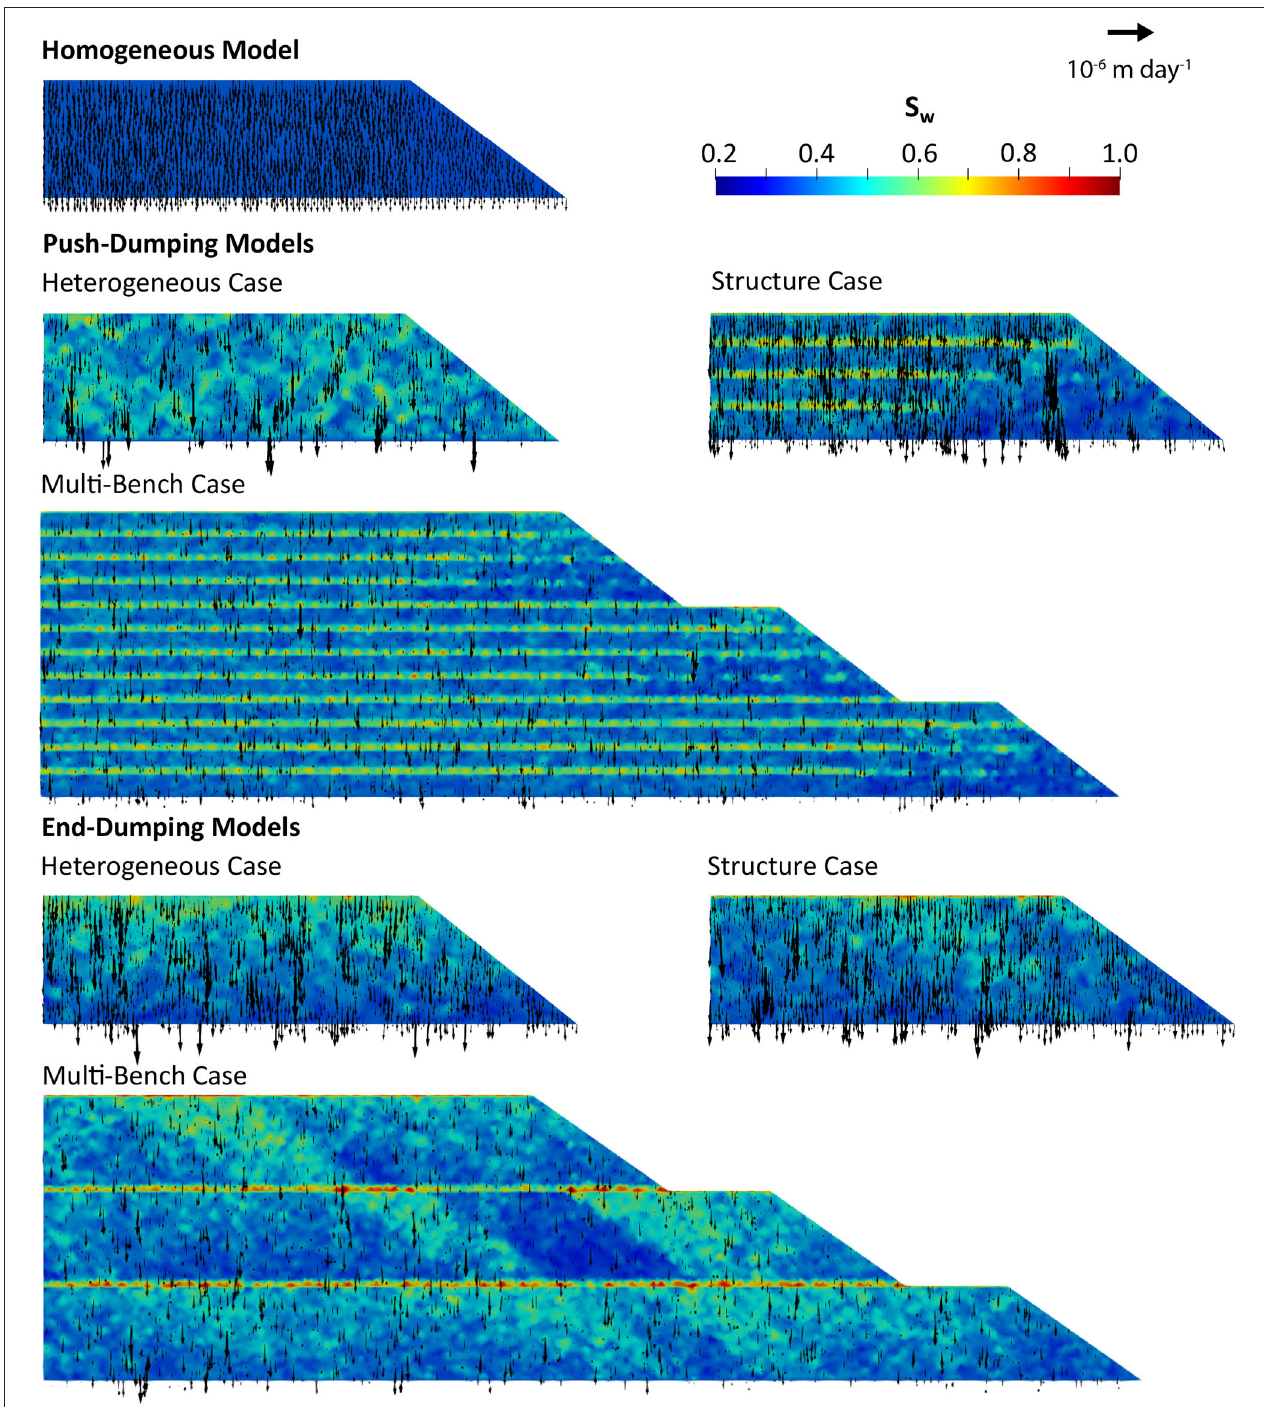
FIGURE 5 | Saturation profiles with Darcy flux vectors represented as arrows (top right: arrow for scale) which indicate flow direction and their relative magnitude to illustrate influence of physical heterogeneities on flow. In all cases, gravity drainage is the dominant flow control, as flux vectors are predominately downwards in all cases. The boundary condition at the base was set to h = − 0.5m for all cases to mimic discharge into a basal drainage layer.